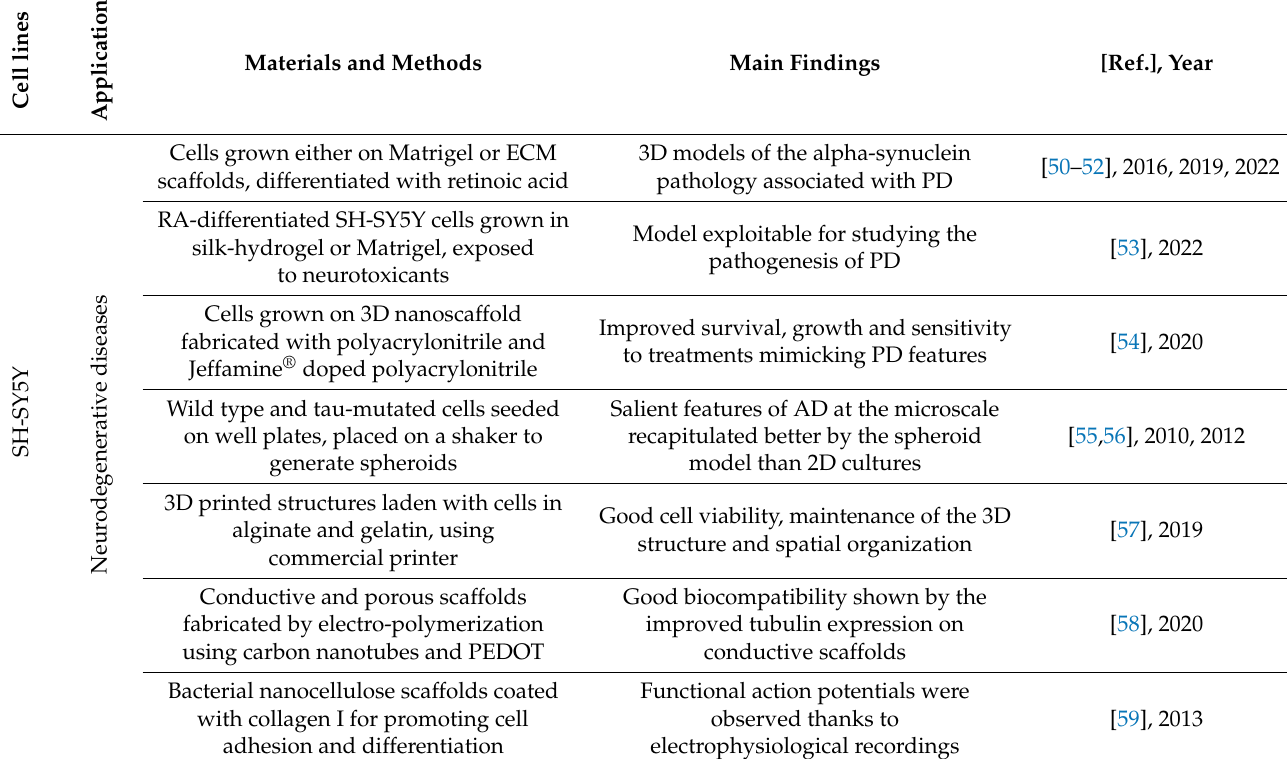
Table 4. Three-dimensional models involving neuroblastoma cell